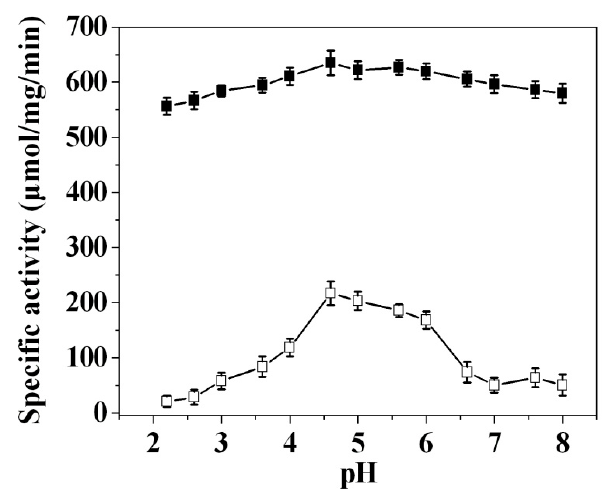
Figure 3. pH stability of laccase entrapped by protocol I ( ■ ) and free laccase ( □ ).